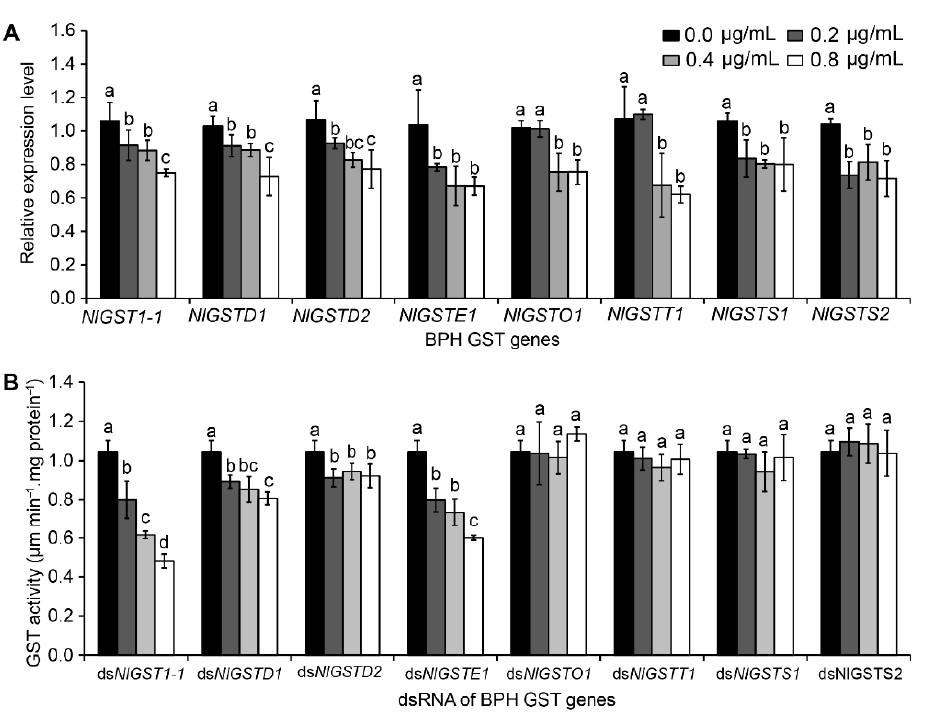
Figure 2. Effect of GST dsRNAs on each GST gene transcriptional level and GST activity. The second- or third-instar BPH nymphs were fed with artificial diets supplemented with 0 (containing 0.4 μg/mL GFP dsRNA), 0.2, 0.4, and 0.8 μg/mL of the indicated dsRNA for 3 days. The transcriptional level of target gene ( A ) and GST activity ( B ) in the nymphs were analyzed. The label “ds + gene” represents the dsRNA of the corresponding GST gene. Data represent the means ± SEM from 4 replicates. Different letters labeled indicate significant differences at p < 0.05. Table 2. Correlation of GST gene transcription level with GST activity in BPH.